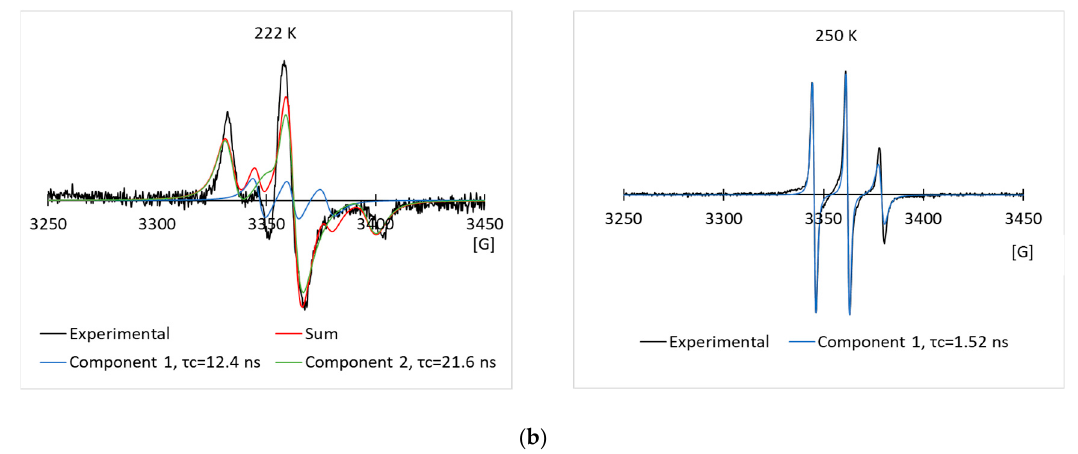
Figure 4. Typical experimental EPR spectra, and their simulated EPR spectra of the 2.0 mg/mL spin labeled L23C in the 5% propylene glycol solution through the freezing process ( a ), and melting process ( b ), respectively.